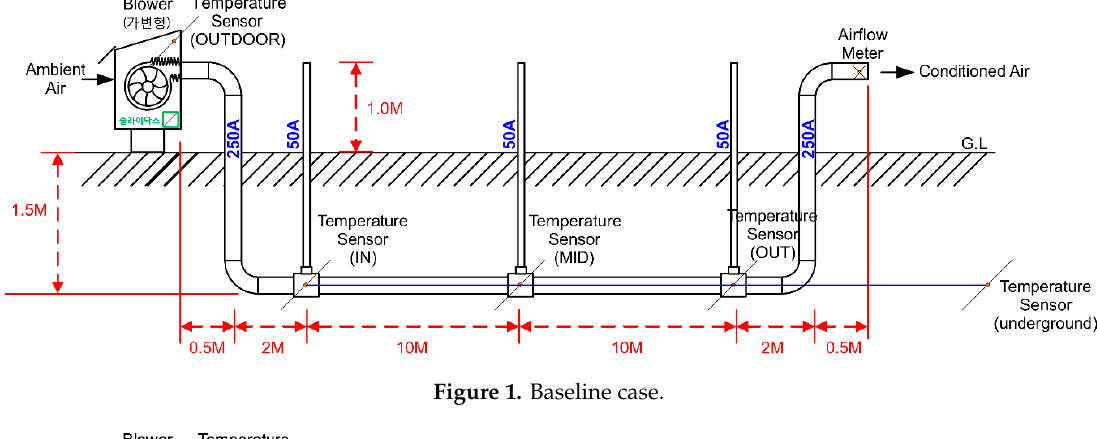
Figure 1. Baseline case.